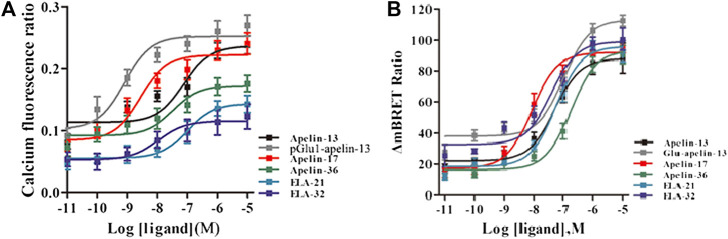

(A) The intracellular Calcium production induced by the six agonists. HEK293 cells stably expressed APJ, and in 30 s, the dose response curve stimulated with six peptides was measured. Data represent mean ± SEM from four independent experiments (Supplementary Table S2). With six peptides (B) stimulation, the dose-response curve of GRK2 recruited to APJ was measured by BRET (at 15 min). p < 0.05 was considered as statistically significant. Data represent mean ± SEM from four independent experiments (Supplementary Table S3).